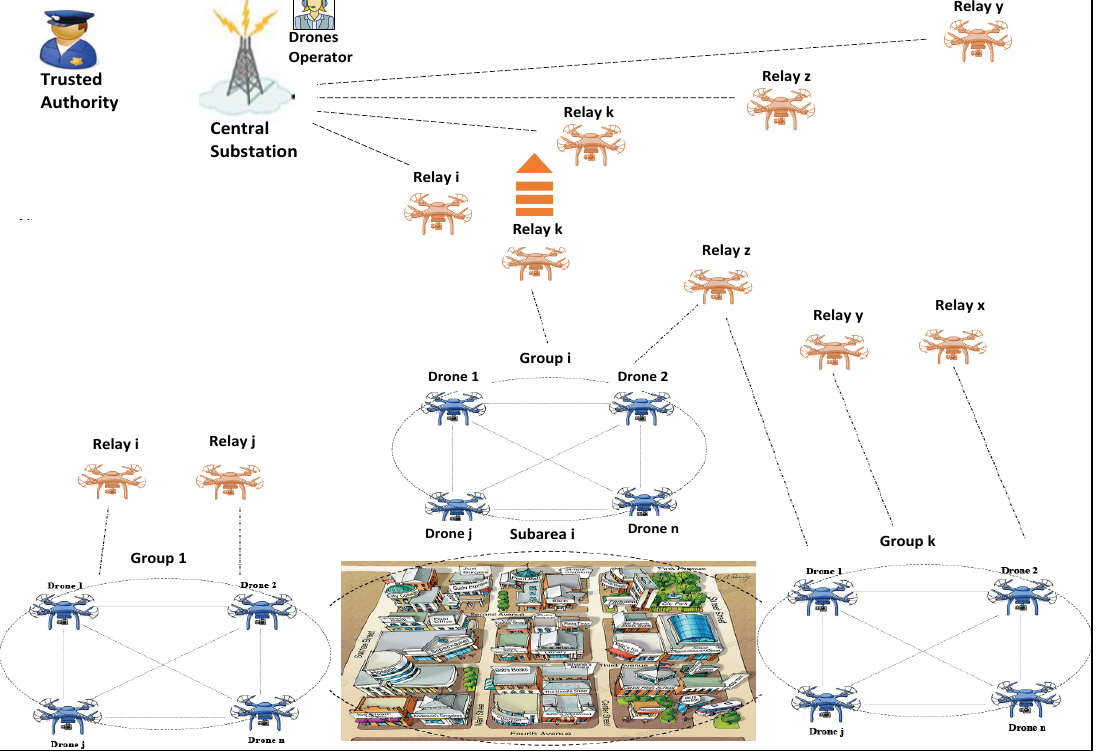
Figure 1. System